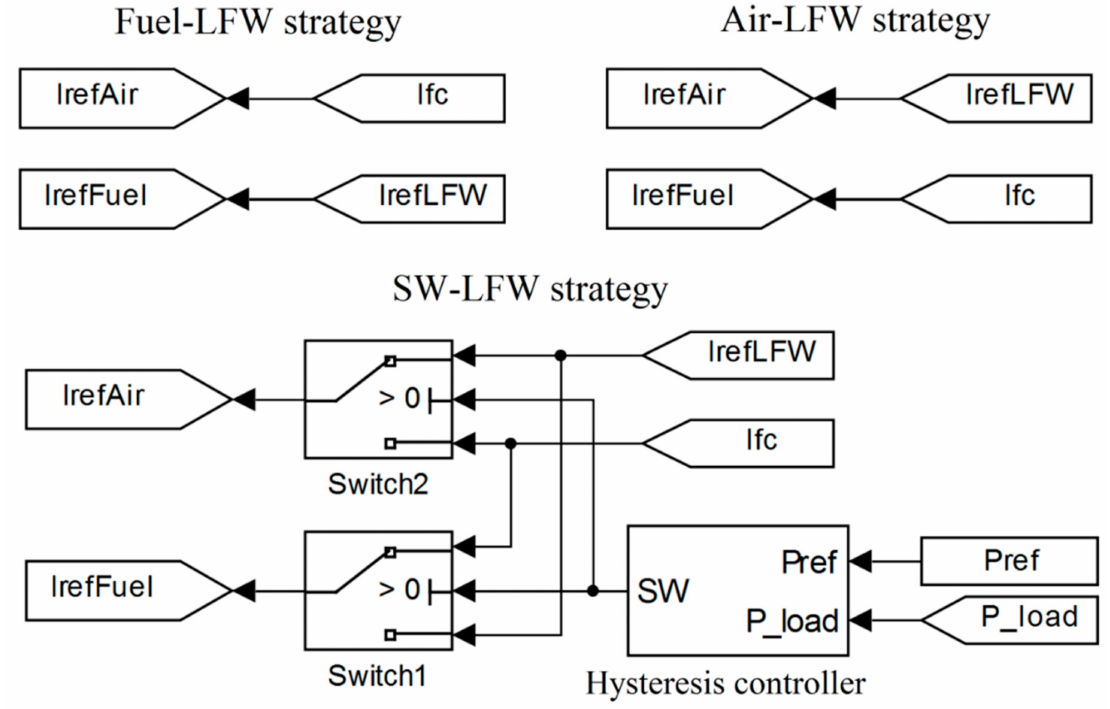
Figure 3. The load-following control